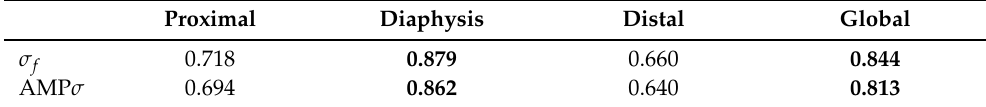
tion coefficients in Table 6; in particular, the Spearman and the power Pearson coefficients in the case GLT = 80 and using the constitutive model IsoH . The Pearson coefficients improved moderately with the use of quadratic elements (C3D10), but only for the good predictors, i.e., those variables that are highly correlated with density. The rest of variables, such as Ψ and the strain magnitudes (not shown), did not improve their correlations. The other types of fit (linear and quadratic) also improved with C3D10, although to a lesser extent. It is noteworthy that the Spearman coefficients were almost identical in both